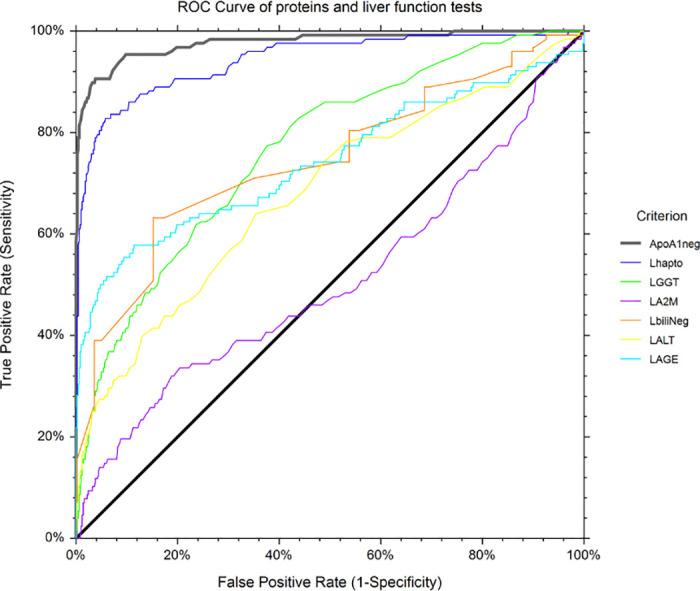
Area under the ROC curves (AUROC) of each FibroTest components.